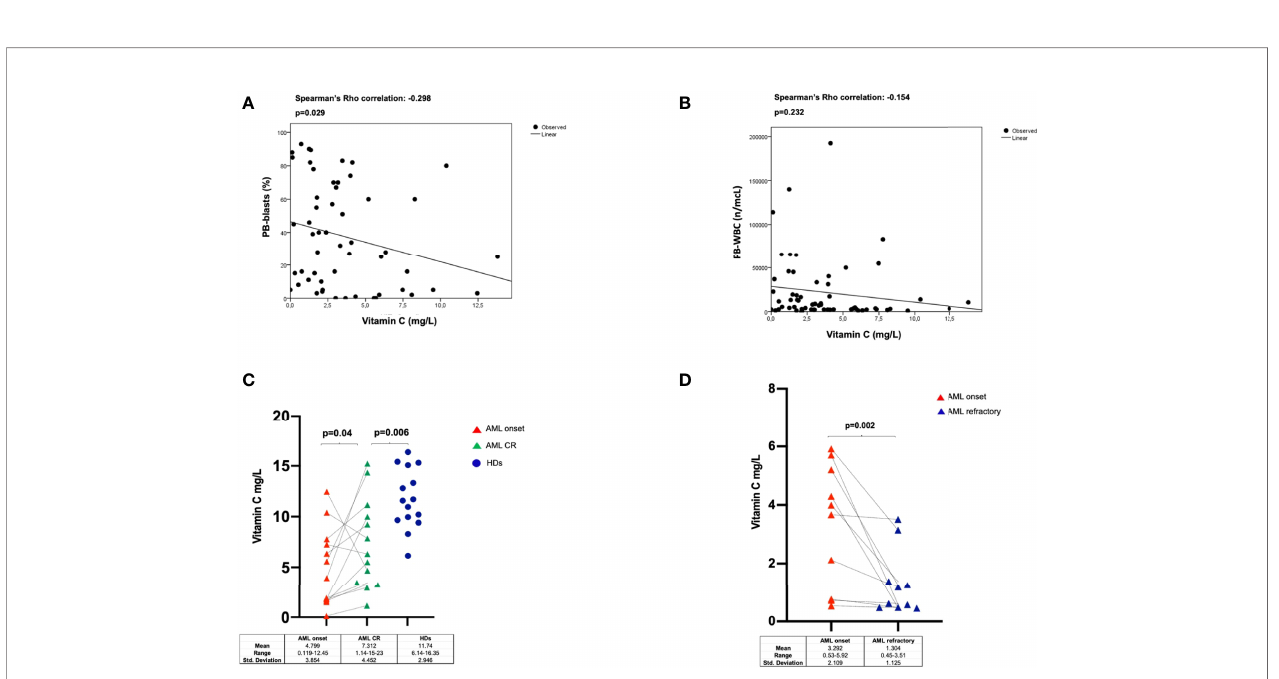
FIGURE 2 | Correlations between Vitamin C levels and PB-blast proportion (A) , or WBC counts (B) in 62 AML patients (including 5 APL cases). Vitamin C plasma levels evaluated in AML patients at diagnosis and at the time of complete remission (paired samples) and in HDs (C) and at disease progression (refractory) (paired diagnostic and relapse samples) (D) . HDs, healthy donors; CR, complete